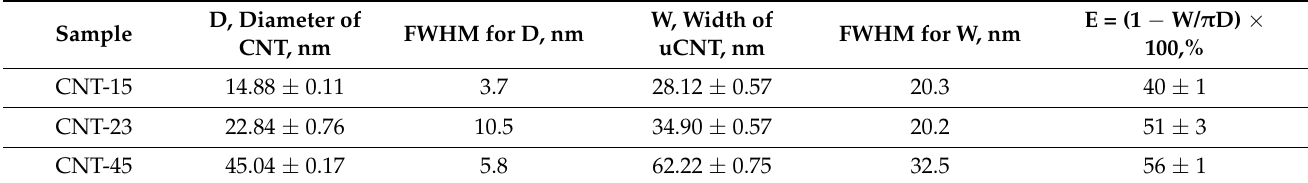
Table 1. The values of average diameters CNTs, the average width of uCNTs, and etching level. Sample